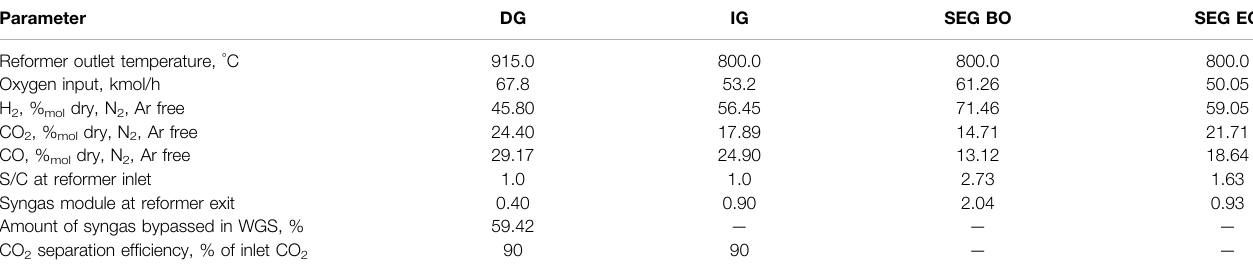
TABLE 2 | Autothermal reformer operating conditions and exit gas composition. Syngas conditioning operating conditions. Parameter DG IG SEG BO Reformer outlet temperature, °